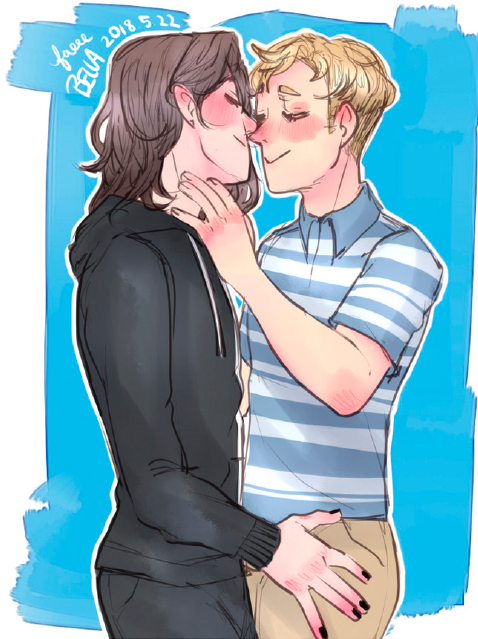
Figure 3. A piece of artwork found under #treebros, showing Evan and Connor in a deep embrace, suggesting a potential romantic relationship between the two characters as imagined by the fandom. Used with permission from @faeee on Tumblr (2018).